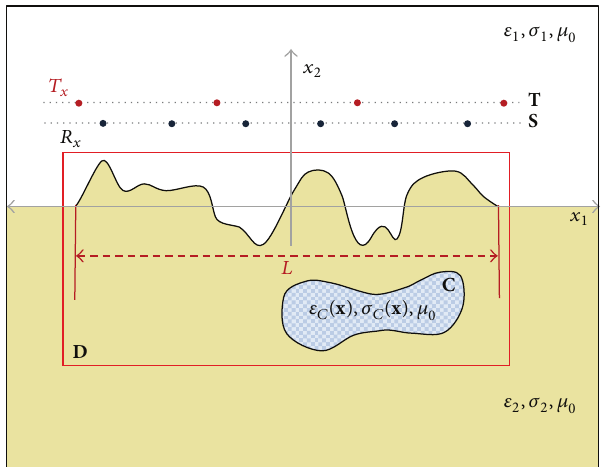
Figure 1: Geometry of the